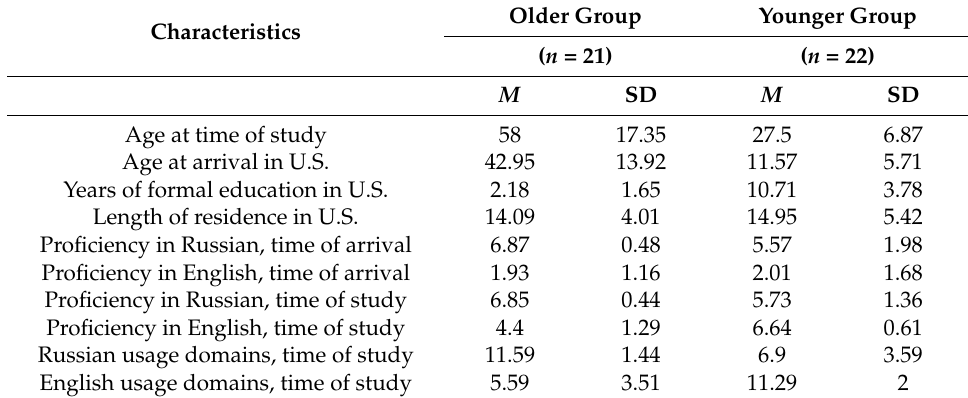
Table 1. Participant characteristics of the two age-groups of Russian–English bilinguals.